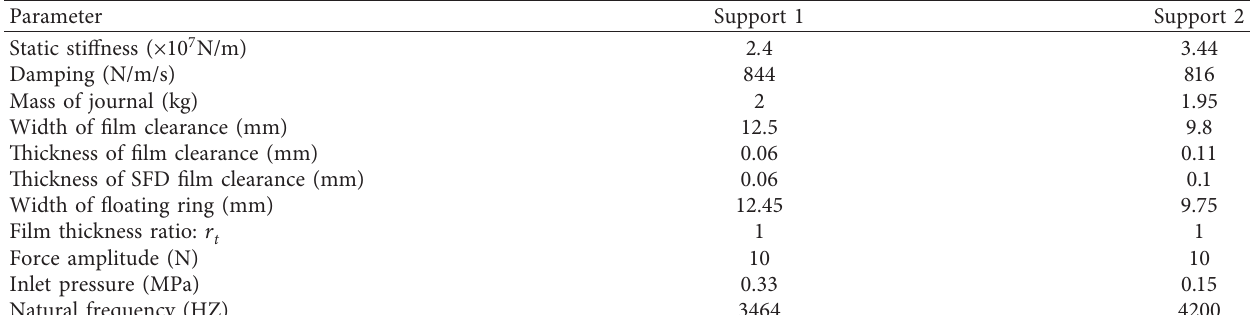
Table 2: The parameters of DCSFD test